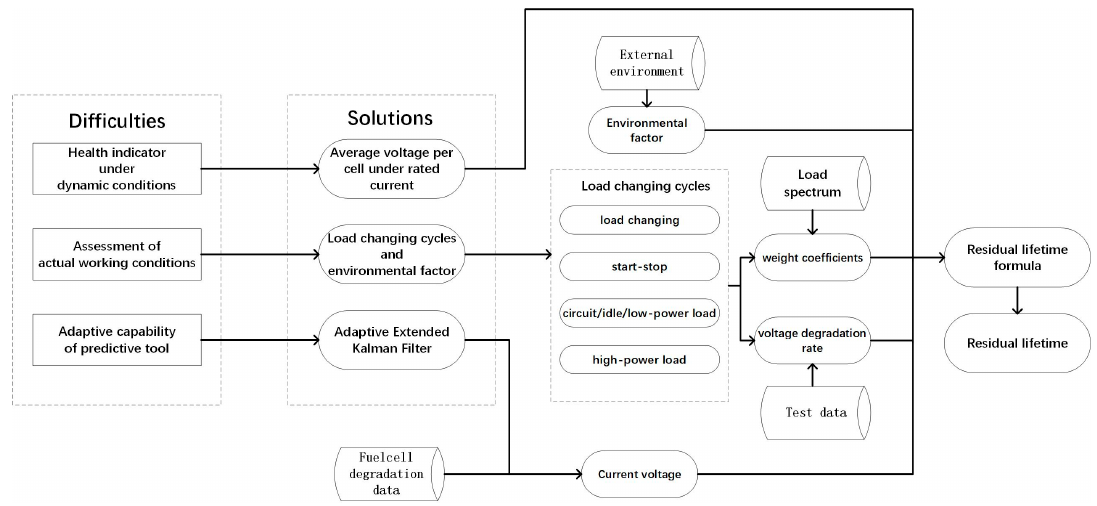
Figure 5. Logic diagram for online proton exchange membrane fuel cell (PEMFC) prediction.